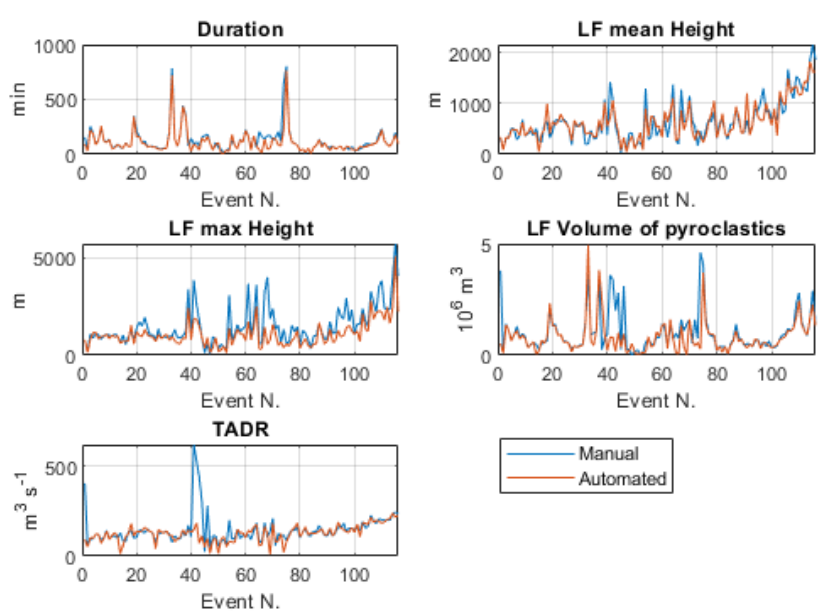
Figure 1. Comparison between the manually and automated estimation of lava fountain features.